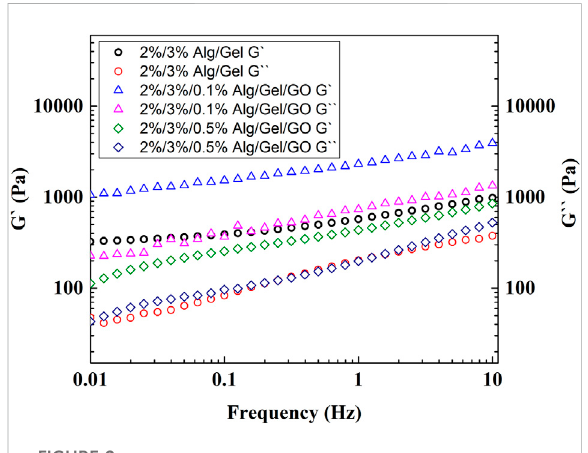
FIGURE 2 Rheological measurements of 2%/3% (w/w) Alg/Gel,